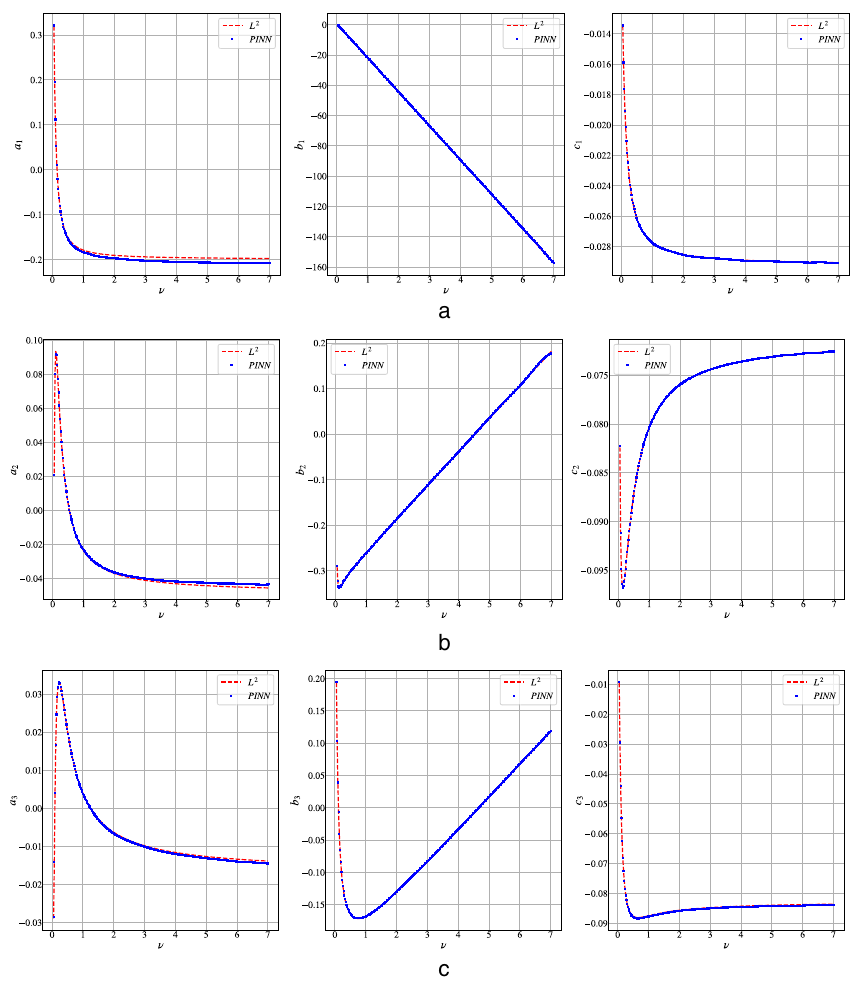
Fig. 3 The results of the POD-Galerkin PINN predictions for the 1st, 2nd and 3rd components of the velocity, pressure and convective reduced coefficients for the first numerical test. The plots compare the reduced coefficients with the L 2 projection coefficients of the test velocity and pressure fields onto the corresponding POD modes. The red-dashed lines refers to the L 2 projection coefficients, while the blue-dots correspond to the reduced coefficients obtained by the PINNs. The coefficients are plotted versus the physical viscosity values at which the test data was generated. (a) The first reduced coefficients for velocity, pressure and convective terms compared to the ones obtained by the L 2 projection. (b) The second reduced coefficients for velocity, pressure and convective terms compared to the ones obtained by the L 2 projection. (c) The third reduced coefficients for velocity, pressure and convective terms compared to the ones obtained by the L 2 projection and pressure which, respectively, read as: